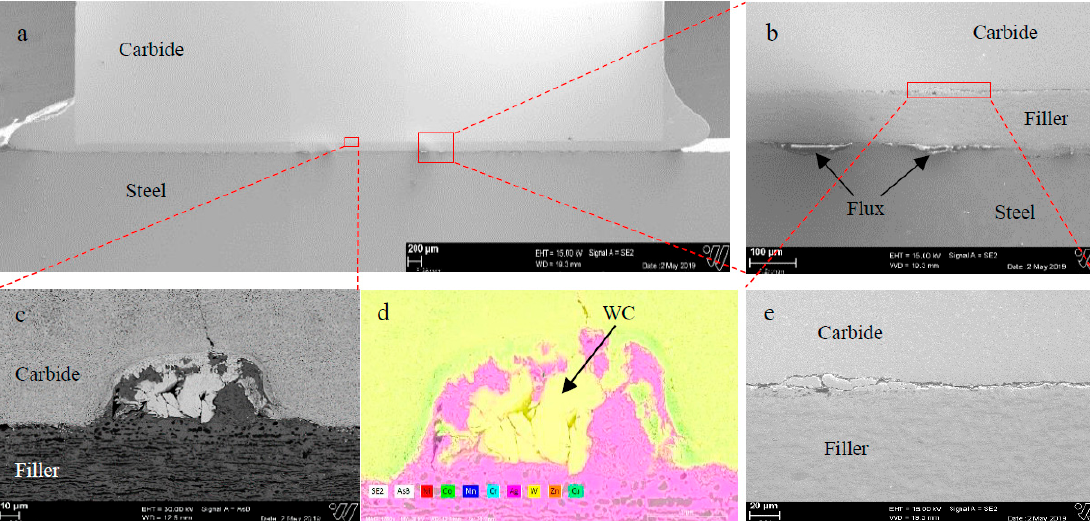
Figure 7. SEM image of ( a ) complete cross section of a sample 4 of brazed joint with holes on carbide surface ( b ) Cross section of surface hole ( c ) Cross section of region without holes showing remnant flux ( d ) energy dispersive X ‐ ray spectroscopy (EDX) color mapping of hole ( e ) carbide/filler interface.